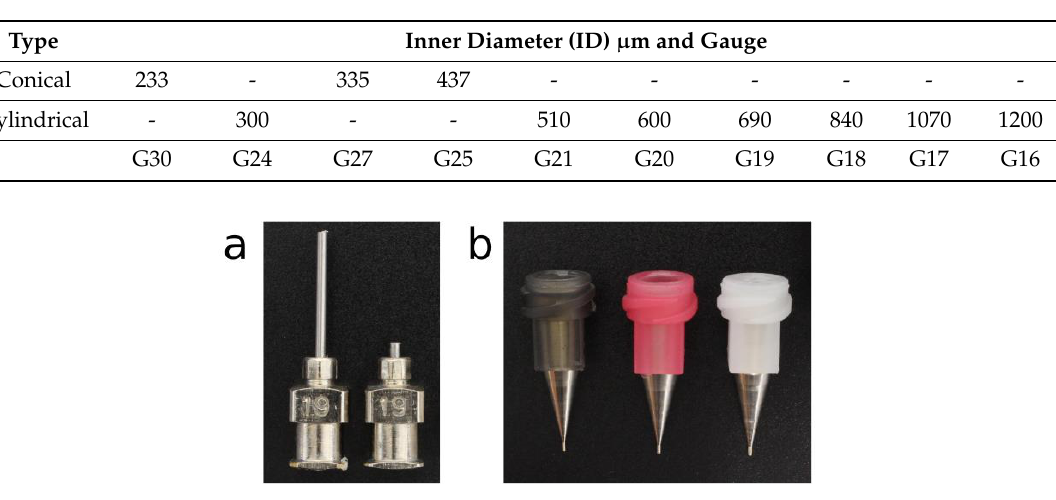
Figure 1. The nozzles selected for the experiments. ( a ) Stainless steel cylindrical standard (left) and shortened (right) nozzles of gauge 19 (G19). ( b ) Conical nozzles of gauge 30 (G30), 27 (G27), and 25 (G25) respectively, from left to right.